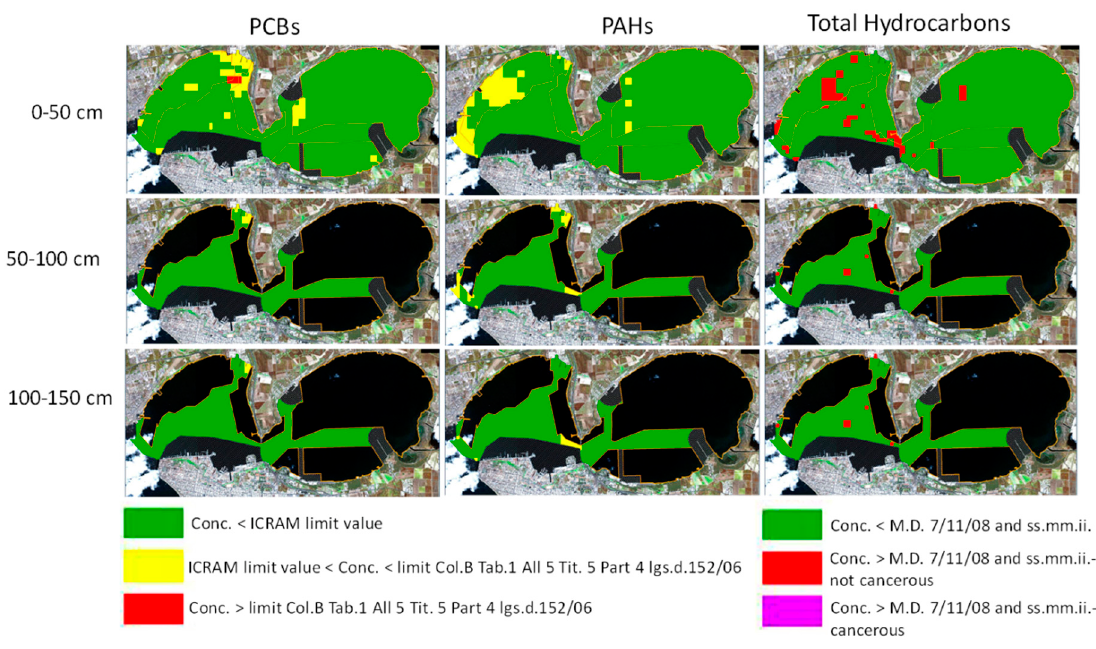
Figure 8. Organic compound concentrations map (adapted from [42]).